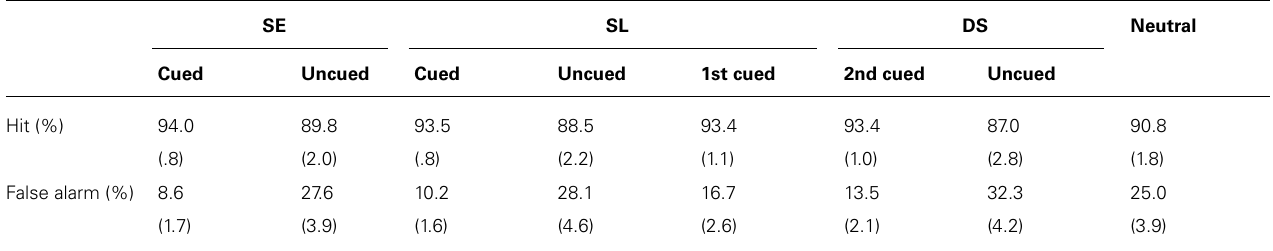
Table 2 | Mean hit rates and mean false alarm rates for each condition in Experiment 2 (Standard errors are shown in parentheses).